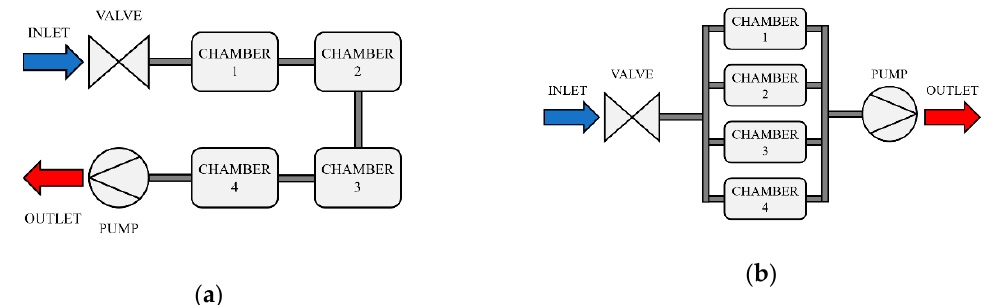
Figure 6. Optical electronic nose airflow pathways: ( a ) series configuration; and ( b ) parallel configuration.